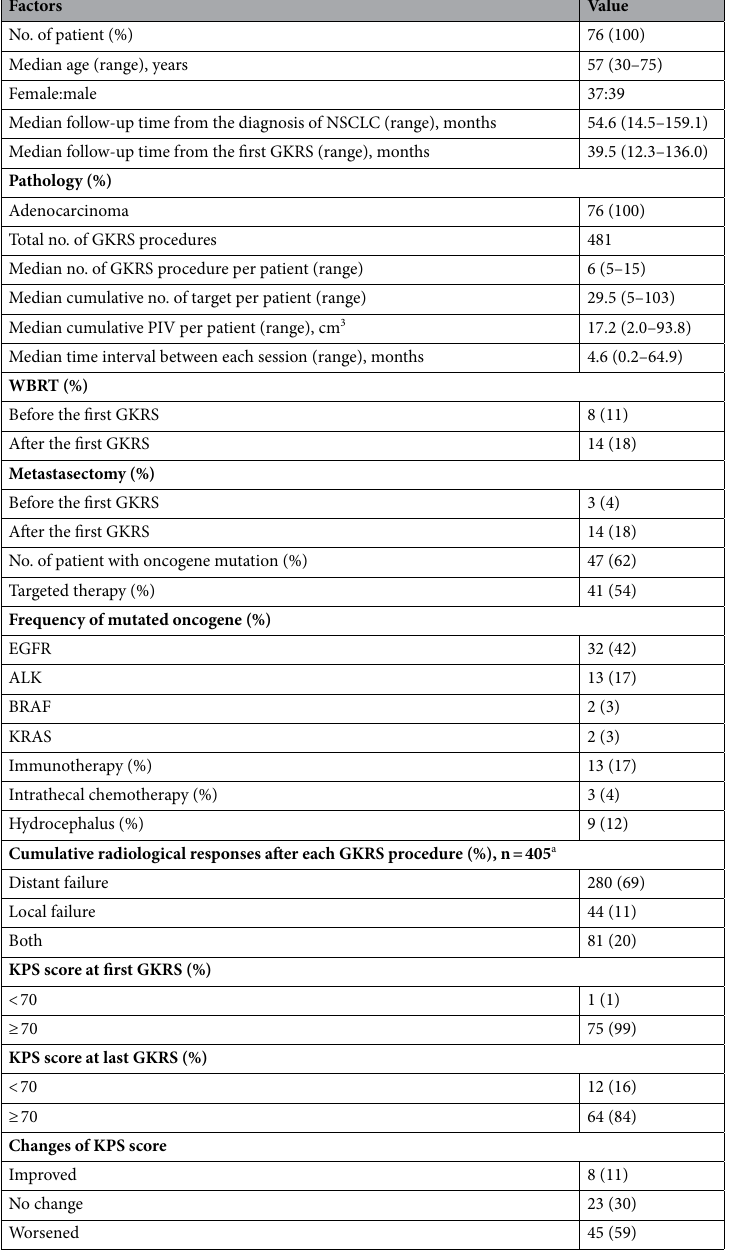
Table 1. Characteristics of the 76 patients who underwent multiple courses (≥ 5) of GKRS. GKRS gamma knife radiosurgery, PIV prescription isodose volume, WBRT whole-brain radiotherapy, KPS Karnofsky Performance status. a Cumulative radiological responses were investigated in 405 cases of repeated GKRS